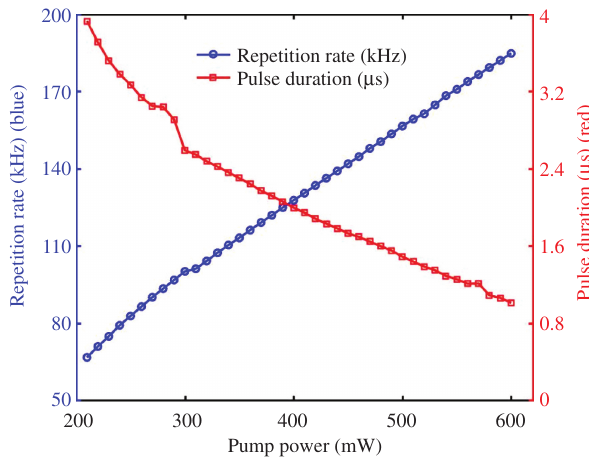
Figure 10: Pulse repetition rate and pulse duration versus the pump power.